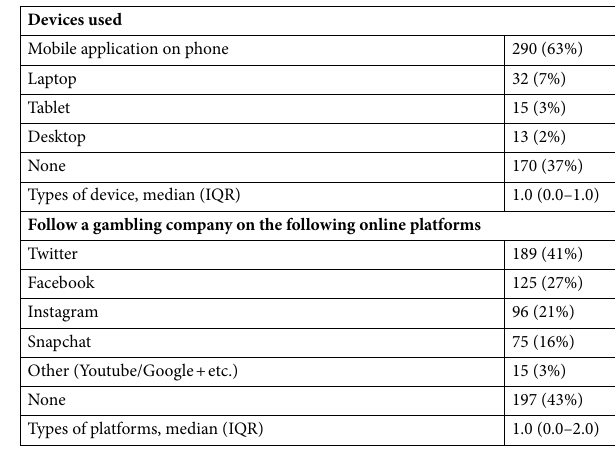
Table 4. Online gambling habits amongst current gamblers.